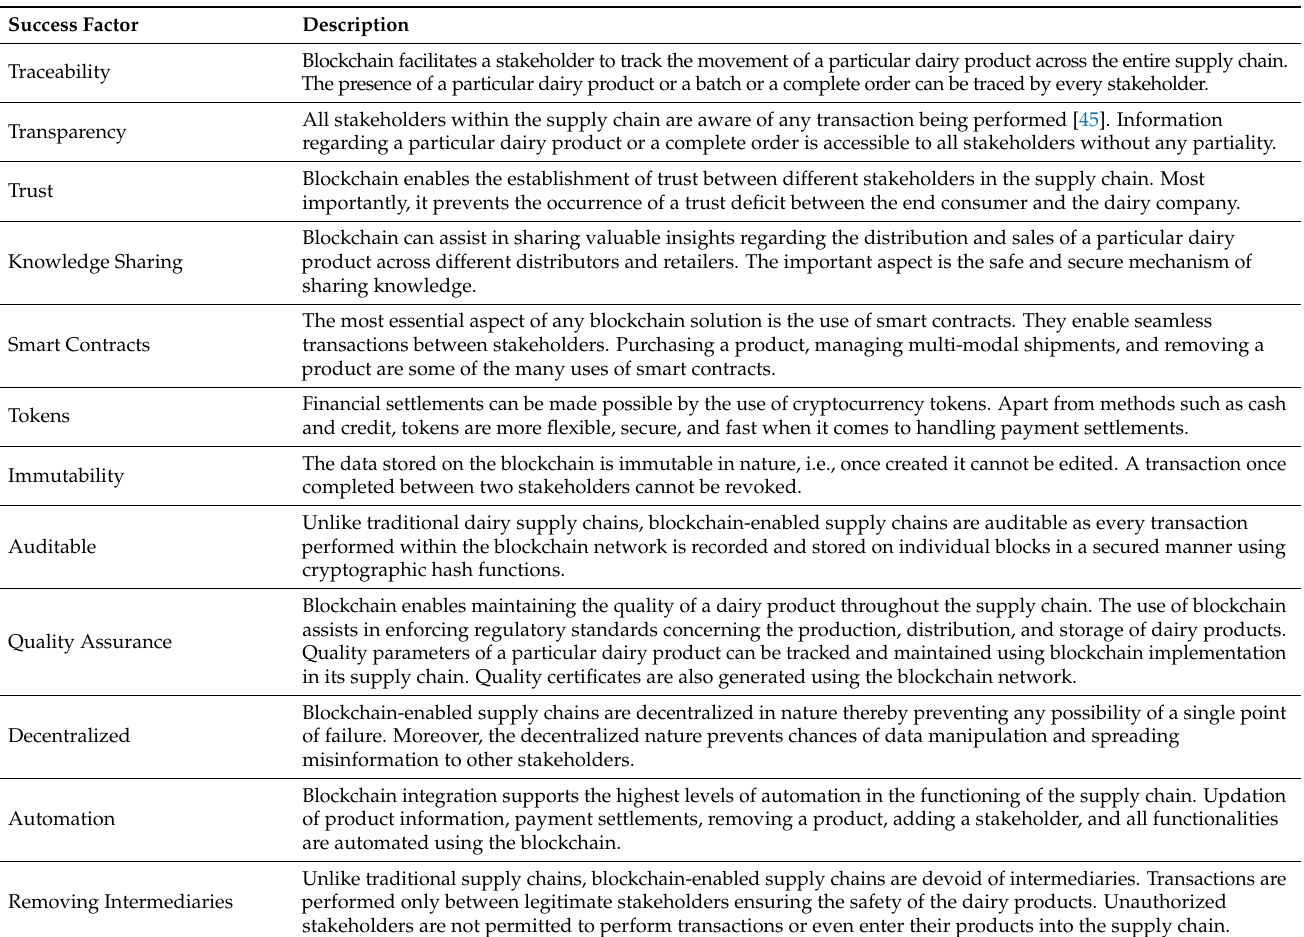
Table 4. Description of Blockchain Success